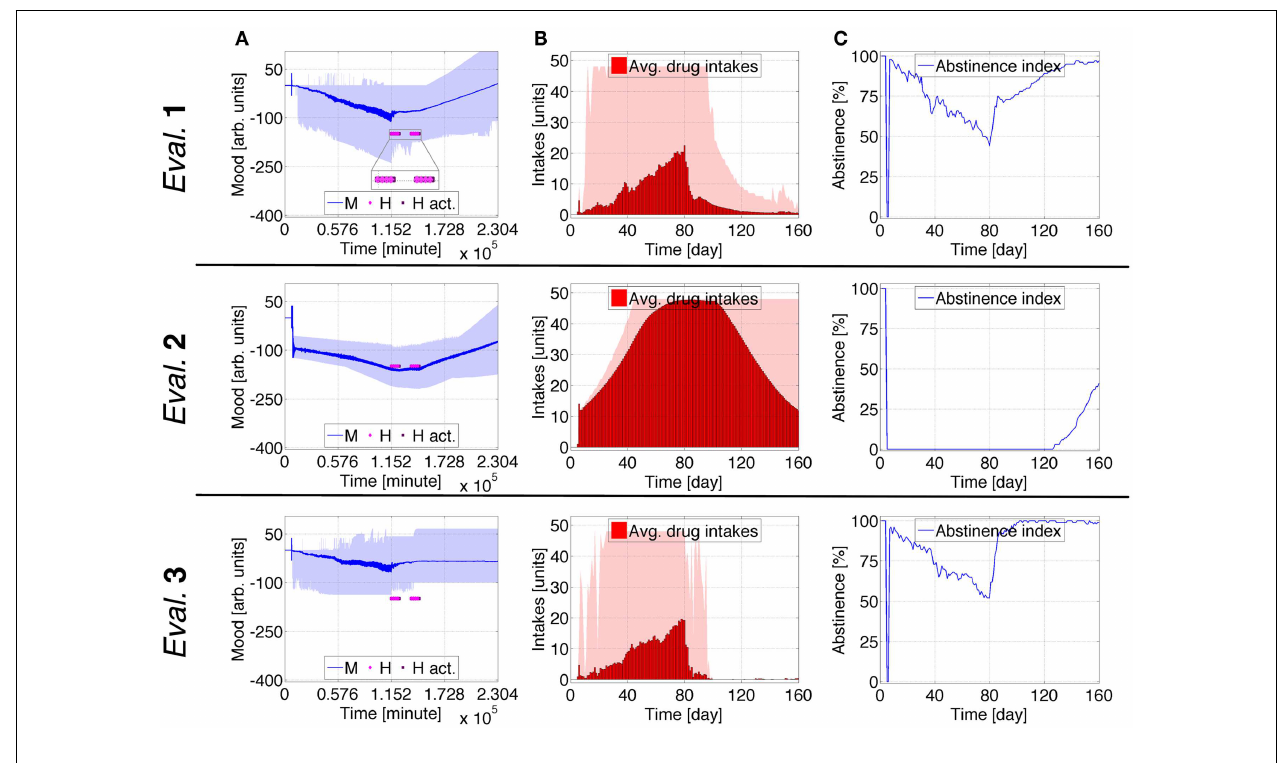
2000, 2040, 2280, 2320, 2360, 2400} [hours] (in light pink) and stays active for 15h (dark pink). (A) shows the evolution of the subject’s mood M ; (B) the average number of drug intakes; and (C) the abstinence index.The gray shades correspond to 95% simulation envelopes.The time-scales are minutes for (A) , and days for (B,C) . Further details of these simulations are reported in FiguresS21 and S22 in Supplementary